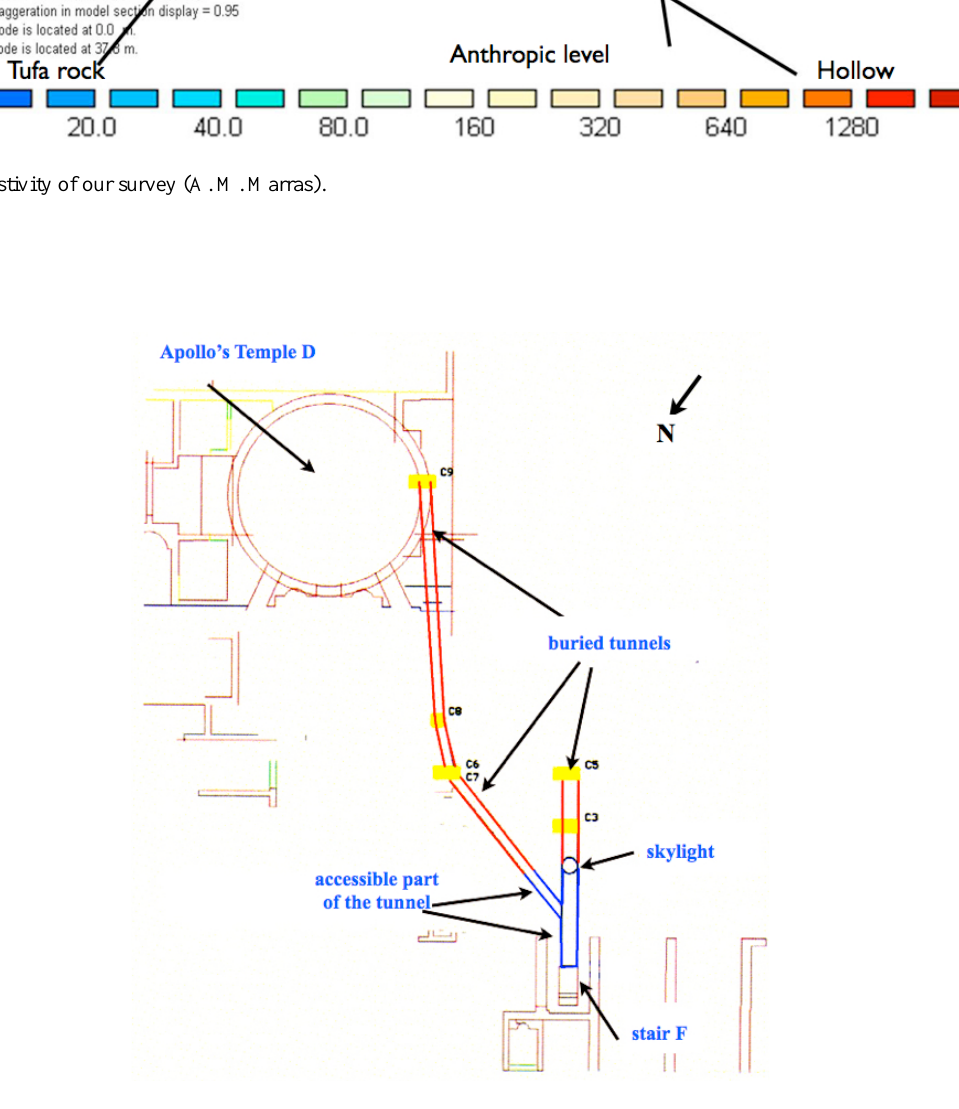
Fig. 13. Our new plan of the subterranean tunnels under the Accademia main porch. The accessible part of the tunnels is outlined in blue, the layout reconstructed with geo-resistivimeter is in red (photo A. M.